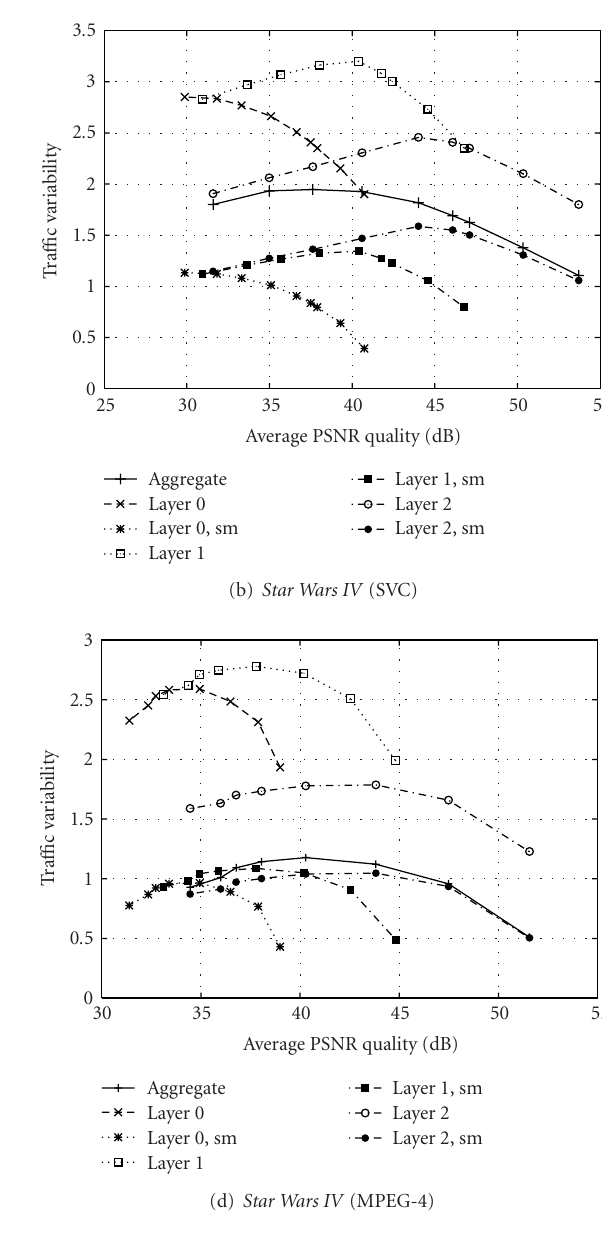
Figure 4: VD curves of three temporal layers ( G16-B3 GoP structure), unsmoothed, smoothed ( sm ), and aggregated ( aggr ), for the Silence of the Lambs and Star Wars IV